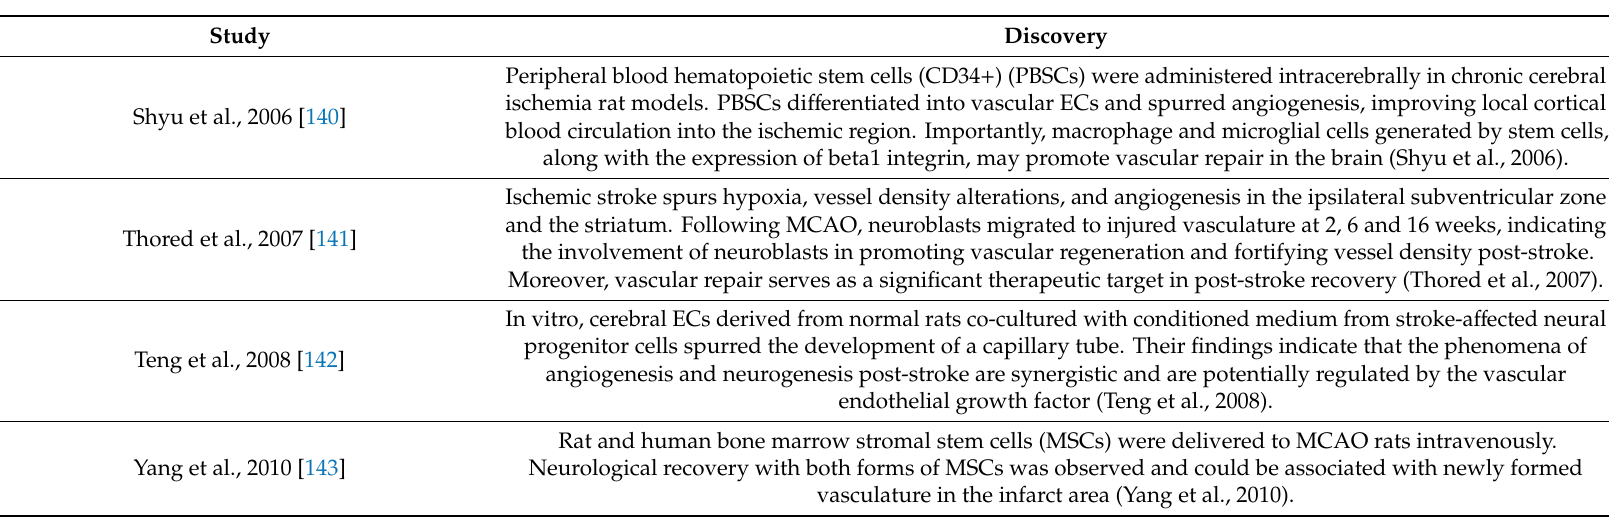
Table 2. Use of Stem Cells for Stroke. This table highlights important studies on the use of stem cells for the repair of stroke-induced microvascular